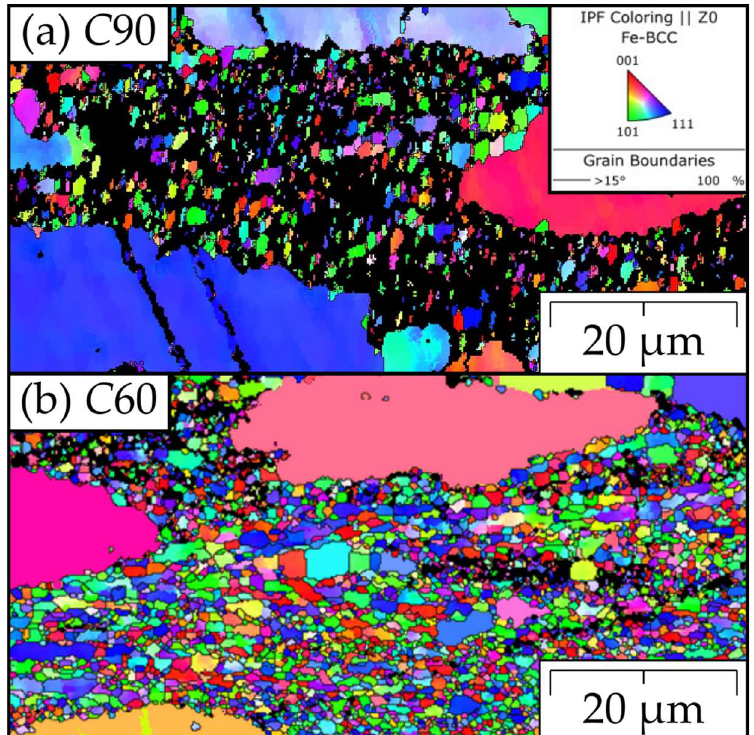
Figure 6. Dependence of average ultimate strength Rm on the time of MA.